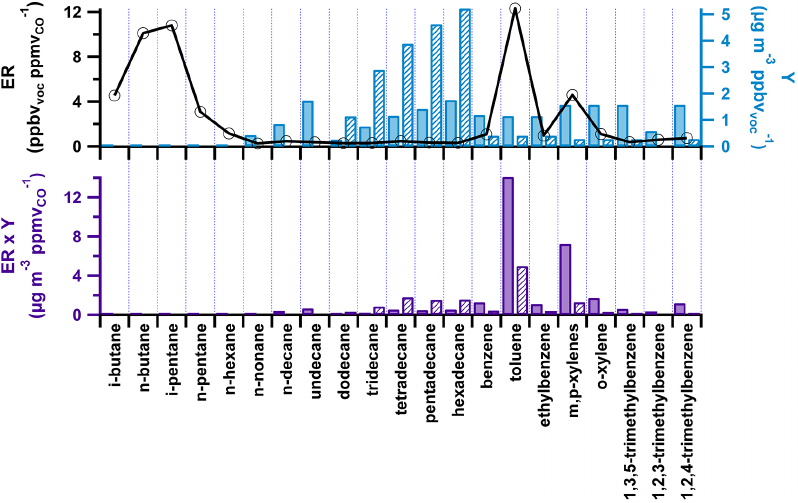
Figure 7. Emission ratios (ER) determined during the MEGAPOLI summer campaign and SOA yields (Y) of relevant VOC precursors (upper panel); products of emission ratios and SOA yields (lower panel). For the C 12 –C 16 IVOCs, the solid bars represent Y (and ER × Y) deter- mined under the most relevant atmospheric conditions regarding the environmental conditions encountered at SIRTA during the MEGAPOLI summer campaign; the dashed bars represent Y (and ER × Y) determined under similar conditions ( C OA = 40µgm − 3 and high NO x